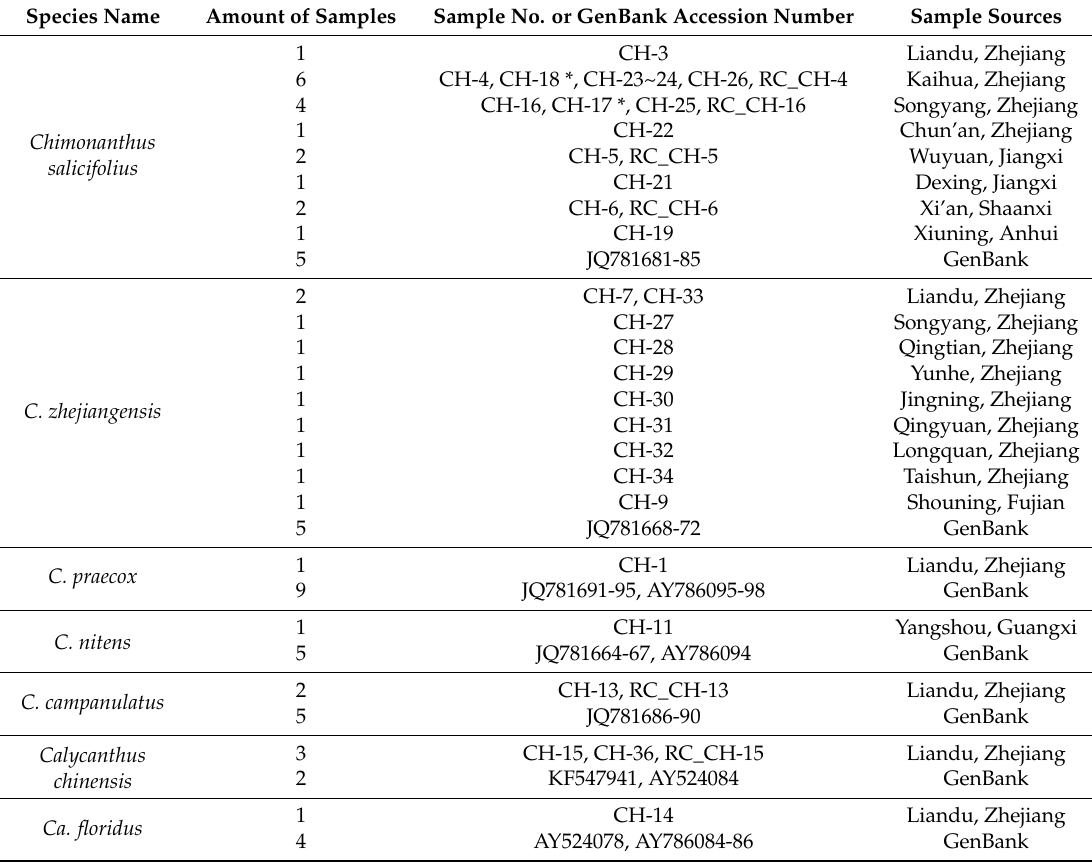
Table 1. Sample detail information of Shi-Liang tea and its closely related